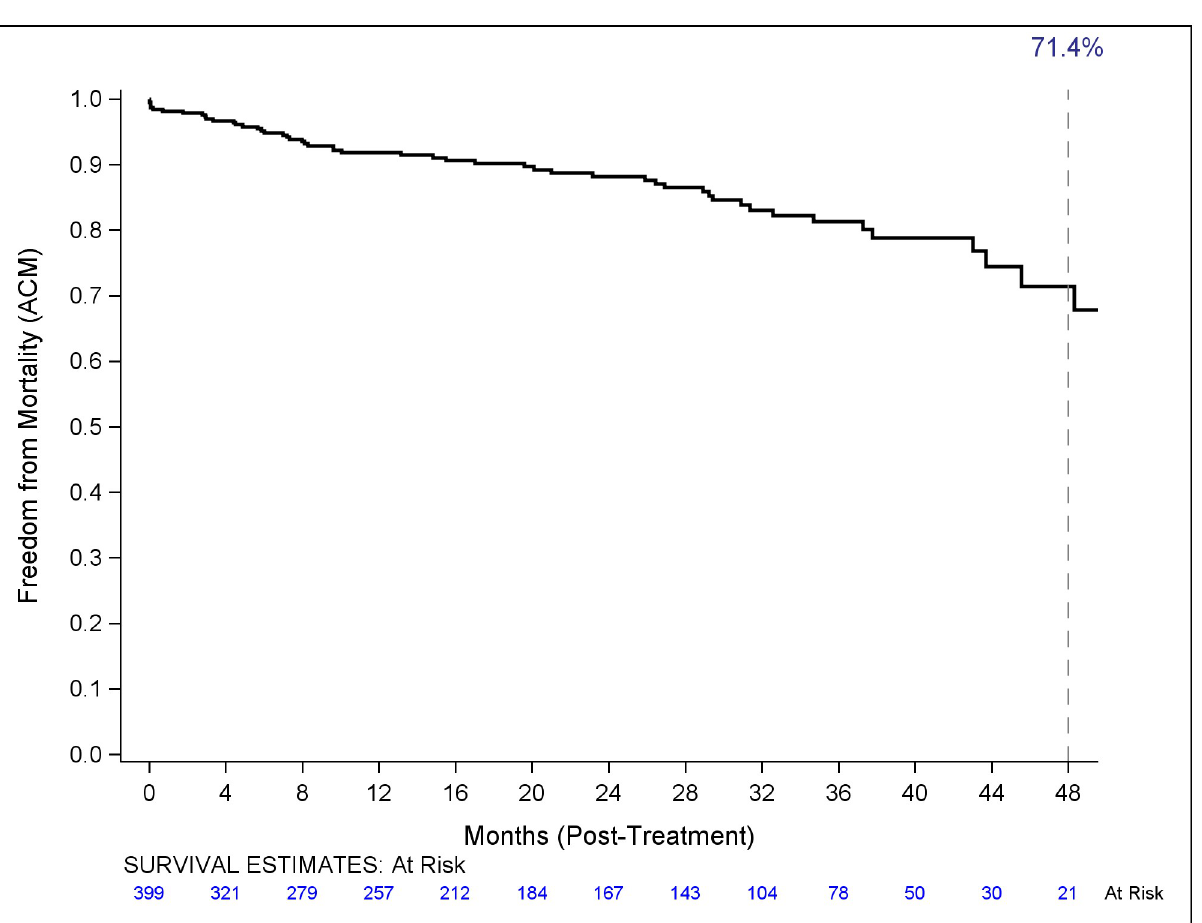
Fig 1. Freedom from all cause mortality. Kaplan-Meier curve illustrating freedom from all-cause mortality to 48 months. Numbers of patients at risk are presented on the x axis.